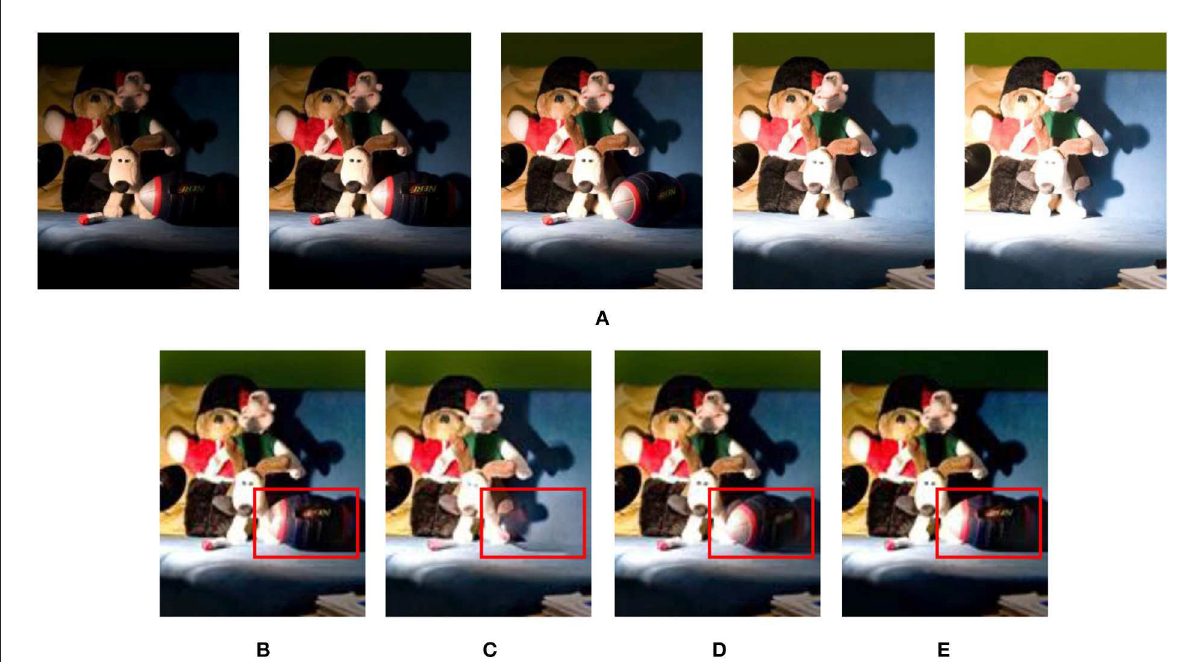
FIGURE3 The results of processing the dynamic scene of the “Puppets” image sequence using the original/improved color dissimilarity features. (A) “Puppets” image sequence; (B) using the original color dissimilarity feature (Li and Kang, 2012); (C) hybrid median filter processing the brightest exposure image; (D) hybrid median filter processing the good exposure image; (E) hybrid median filter processing the darkest exposure image.